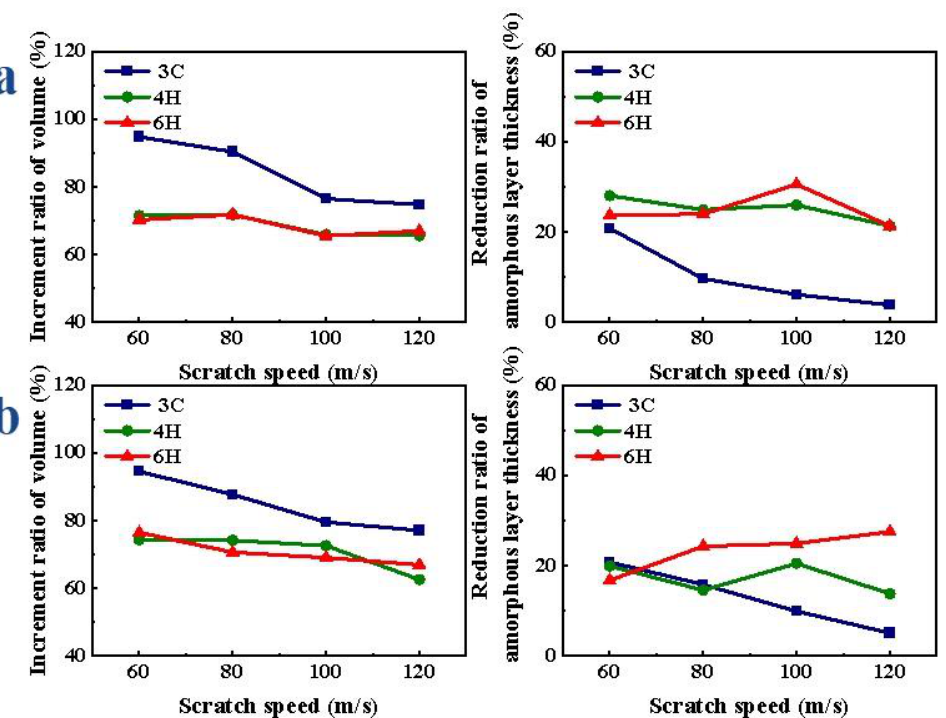
Figure 11. Amorphous atoms’ volume increment and amorphous atoms’ layer thickness reduction ratio of SiC polytypes with different speeds: ( a ) Si-face and ( b ) C-face of SiC.